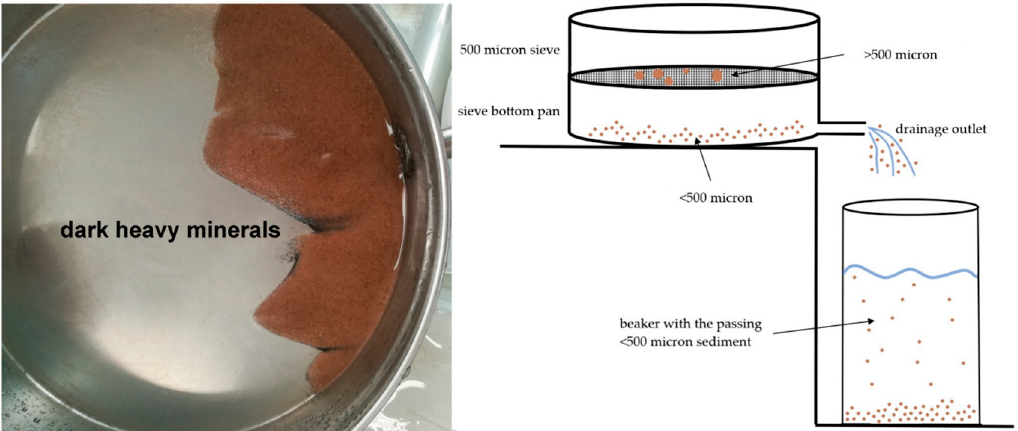
Figure 4. Dense minerals concentrate in the sieve bottom pan during wet sieving with a sketch of the apparatus described in Section 5.1.